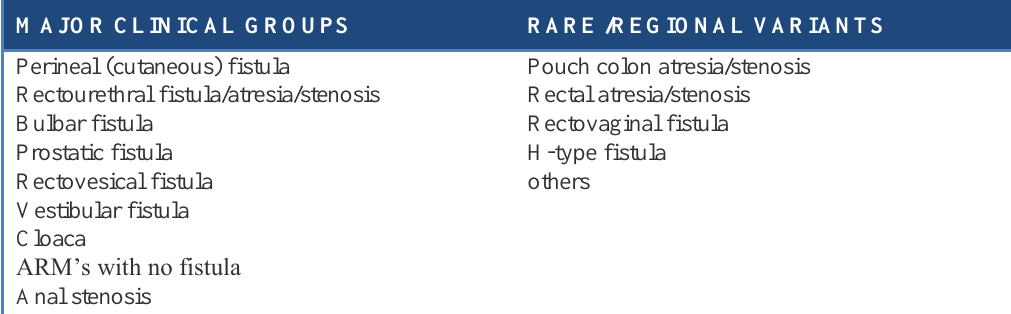
Table 4: Krickenbeck classification of ARM